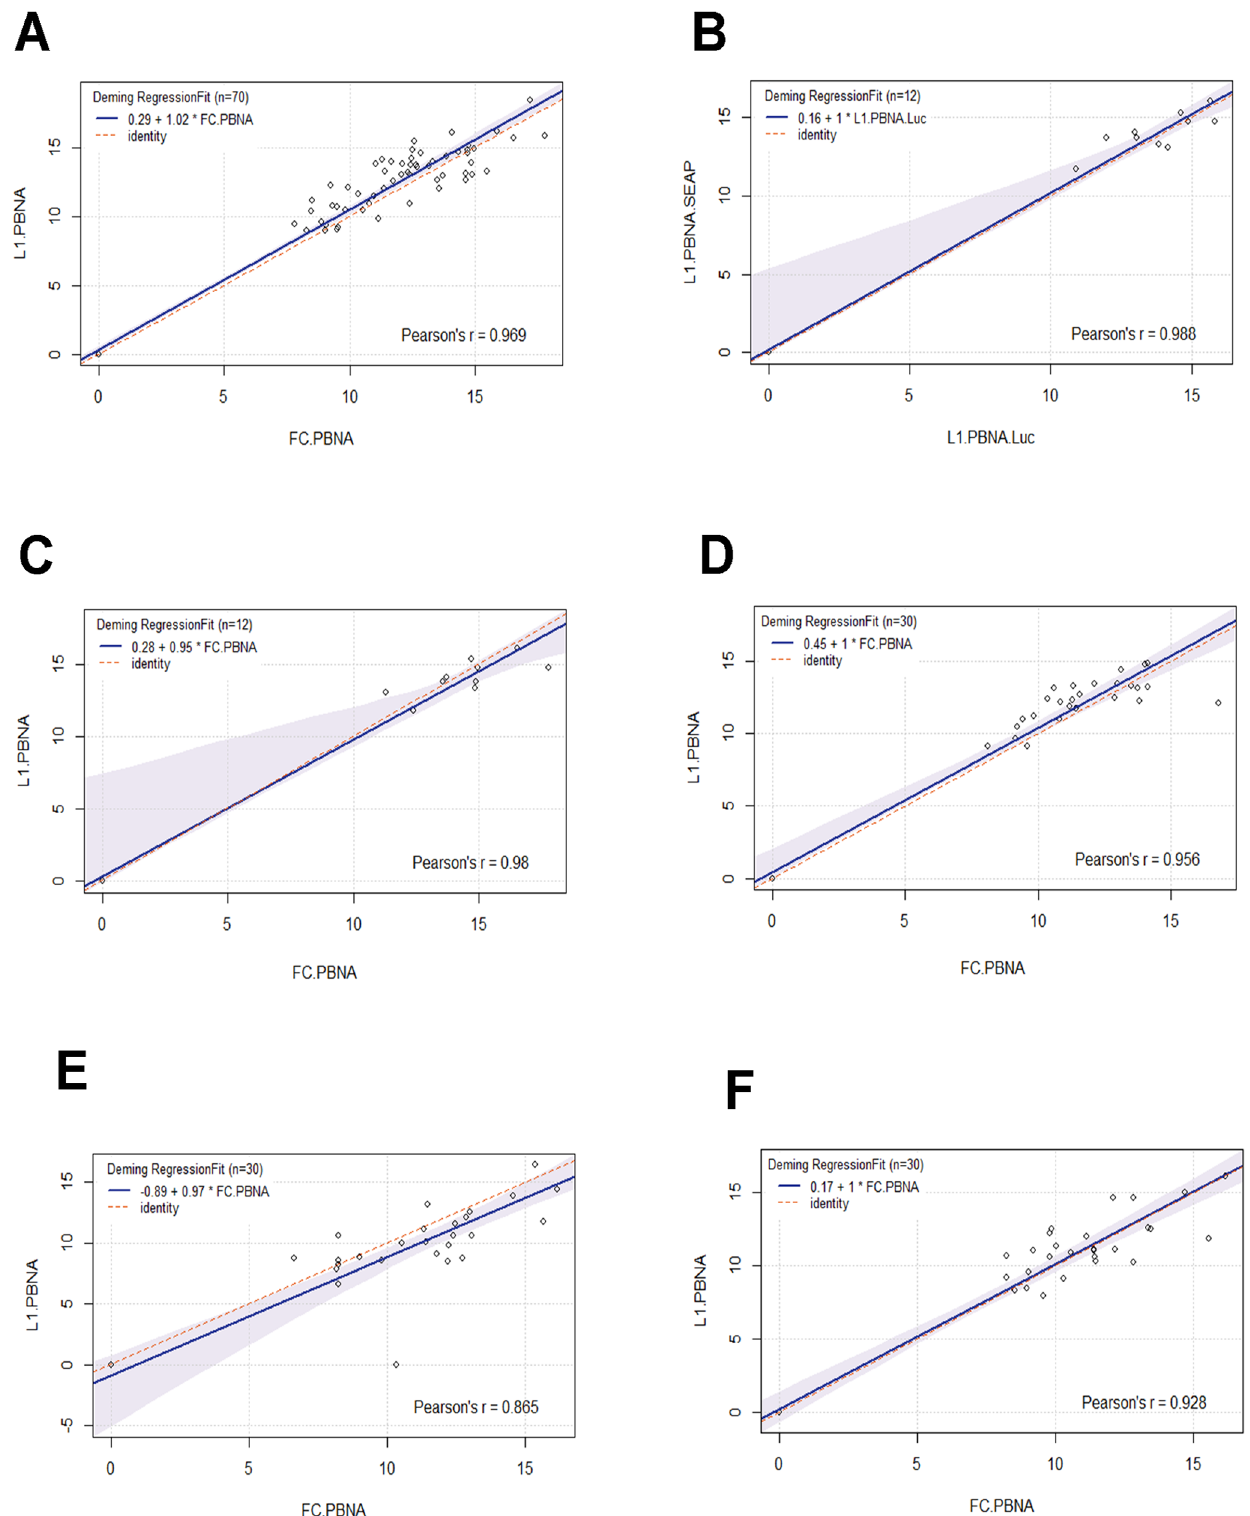
Figure 1. Correlation of neutralization assays. The estimated EC50 values of each patient sample from the respective assays were log2 re- transformed and plotted using R package mcr. Values for Person’s r, slope and intercepts were rounded to 2 decimal places. The 0.95-confidence bounds are calculated with the bootstrap (quantile) method. Comparison of HPV16 VLP vaccinated patient sera (n=70) in FC-PBNA versus L1-PBNA (A). Comparison of L1-PBNA (B) and FC-PBNA (C) with previous findings (n=12) by Pastrana and colleagues using SEAP-based L1-PBNA [43]. Comparison of n=30 Gardasil vaccinated patient sera in FC-PBNA and L1-PBNA against HPV16 (D), HPV18 (E) and HPV6(F).